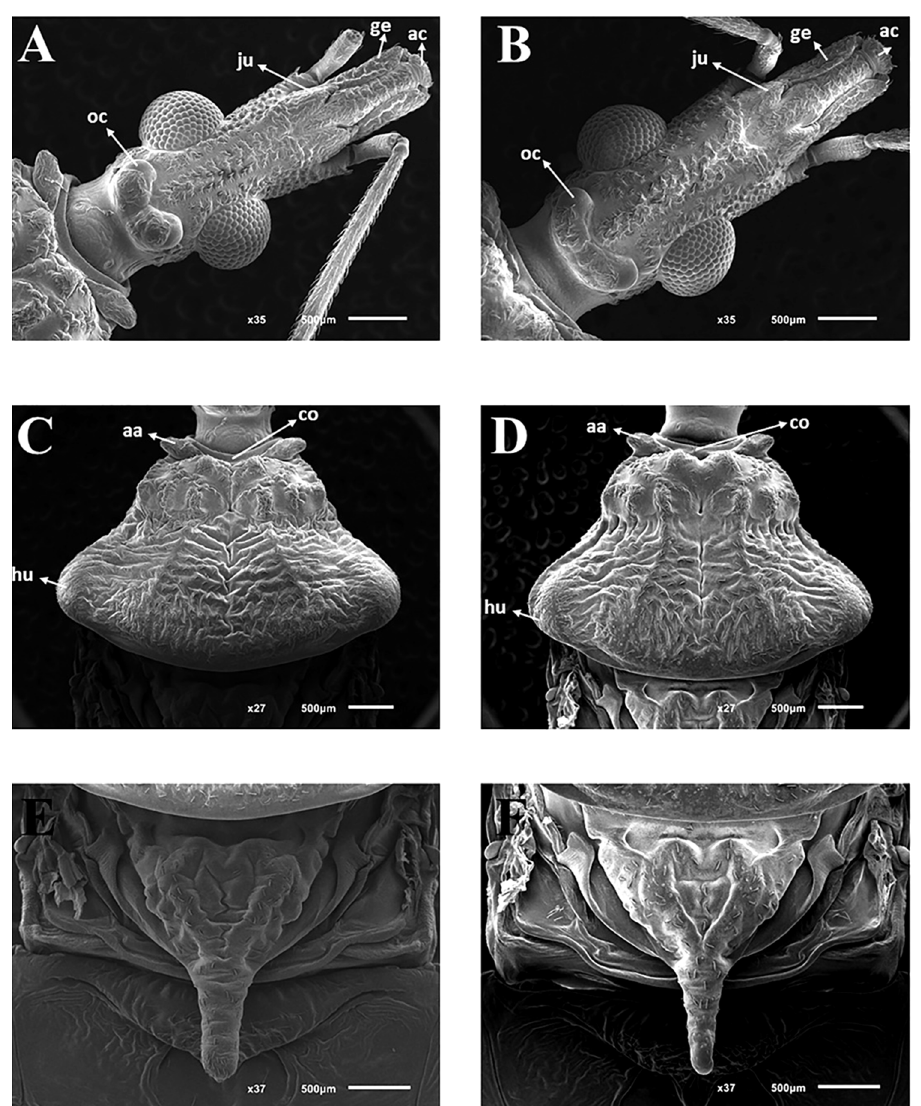
Figure 4. Detail of Head by SEM: ( A ) T. rosai sp. nov. by dorsal view, ( B ) T. sordida by dorsal view; Detail of Pronotum by SEM: ( C ) T. rosai sp. nov. dorsal view ( D ) T. sordida dorsal view; Detail of scutellum by SEM: ( E ) T. rosai sp. nov. dorsal view ( F ) T. sordida dorsal view. ac: anteclypeus; ge: gena; ju: jugum; oc: ocellus; aa: anterolateral angle; co: collar; hu: humeral angles.